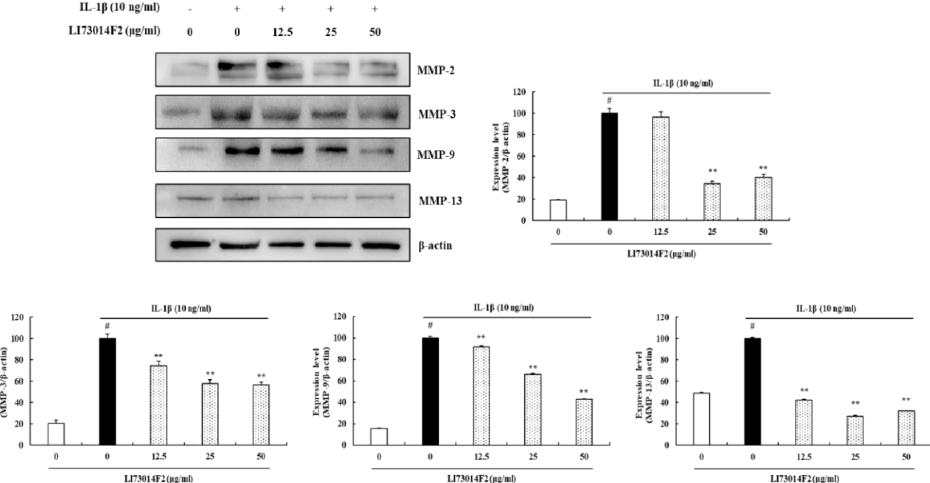
Figure 3. LI73014F2 decreased the production of MMP-2, MMP-3, MMP-9 and MMP-13 in IL-1 β -stimulated HCH cells. HCH cells were treated with IL-1 β (10 ng/mL) alone or in combination with LI73014F2 (0, 12.5, 25 and 50 μg/mL) for 24 h. The expression levels of MMP-2 (62, 72 kDa), MMP-3 (54 kDa), MMP-9 (92 kDa) and MMP-13 (54 kDa) were determined by western blot analysis. western blot bands were analyzed using Image J software. β -actin was used as a control for normalization. # P < 0.05, compared with the vehicle control group. * P < 0.05 and ** P < 0.01, compared with the IL-1 β -treated control group.